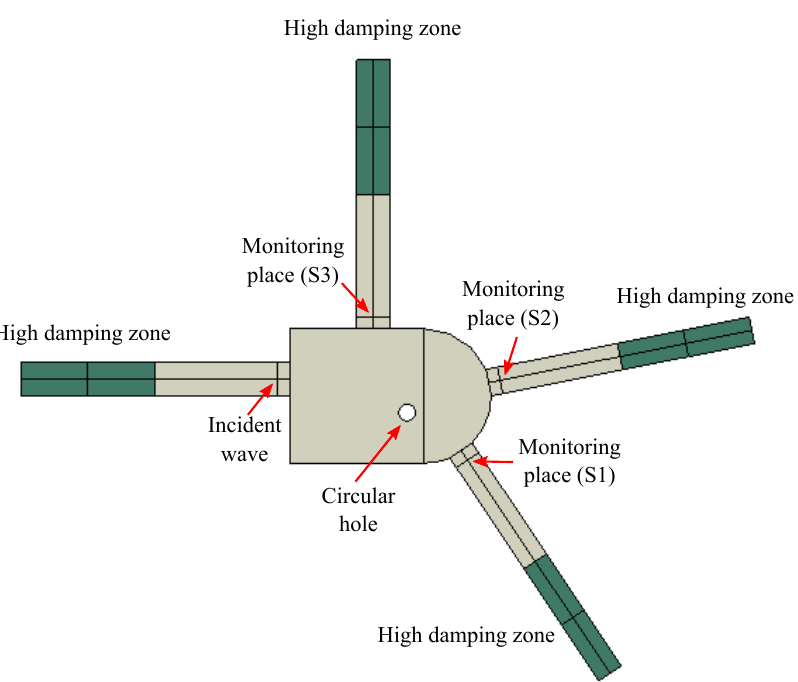
Figure 9. Schematic of the full finite element model for calculating scattering